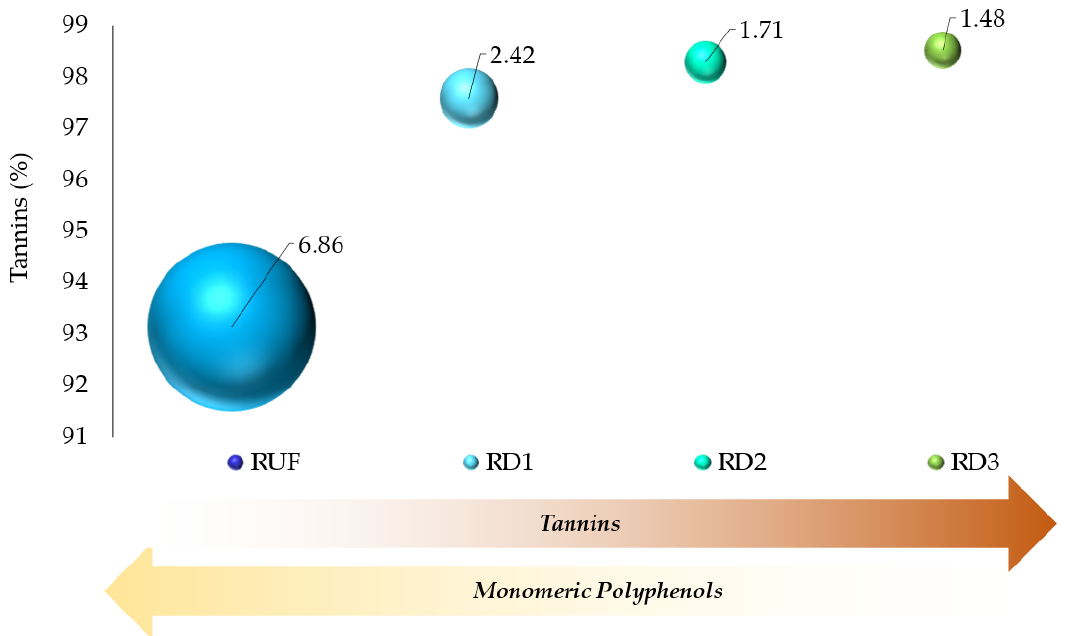
Figure 8. Tannin percentage of diafiltration retentates; labels and sphere radius indicate the polyphenol percentage. Sum of tannins and monomeric polyphenols is normalized to 100.